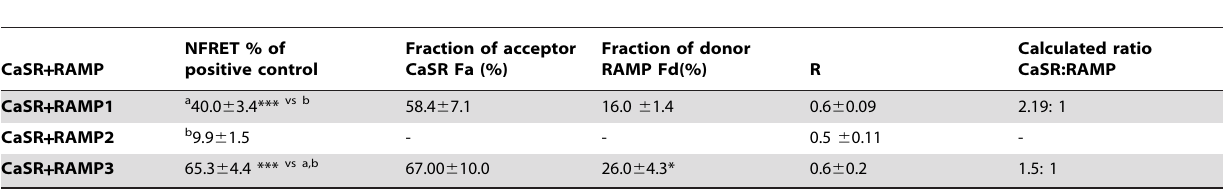
Table 1. Mean and SEM values of cell membrane FRET efficiency and fraction of receptor components involved in FRET between the CaSR and RAMPs.